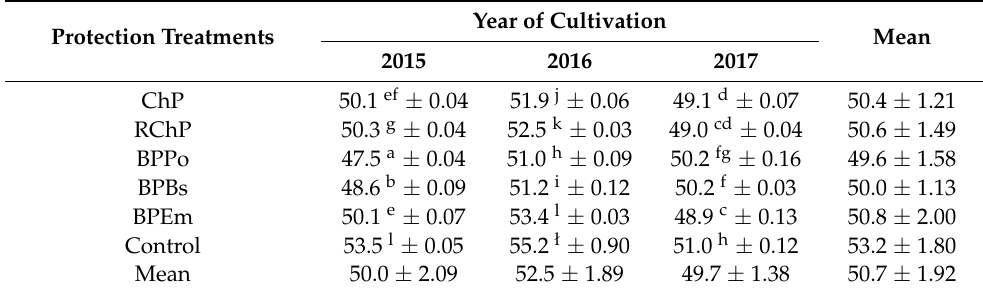
Table 12. Effect of protection treatments and the year of horseradish cultivation on ash alkalinity (0.1 M HCl per 100 g of dry